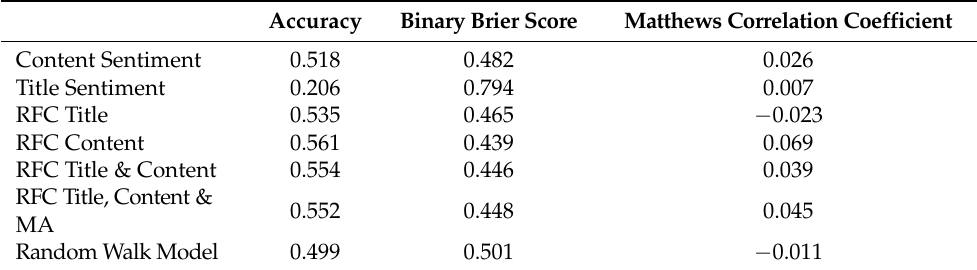
Table 11. Summary of performance